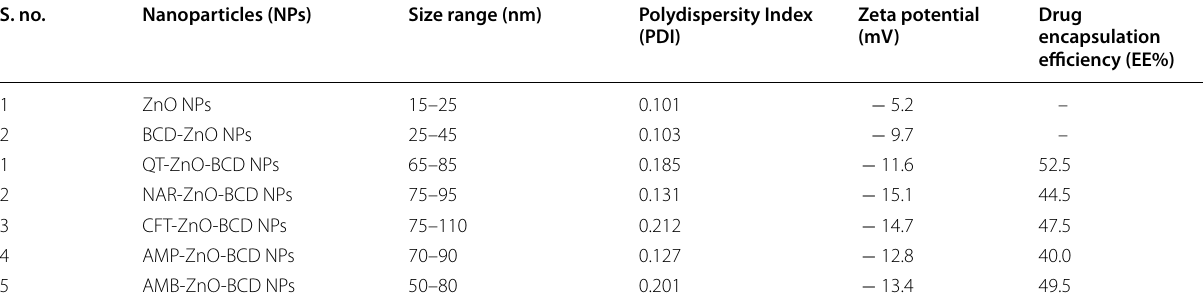
Table 3 Size, size distribution, zeta potential of ZnO NPs and BCD-ZnO NPs and encapsulation efficiency of drug (quercetin, naringin, ceftriaxone, ampicillin and amphotericin B) loaded BCD-ZnO